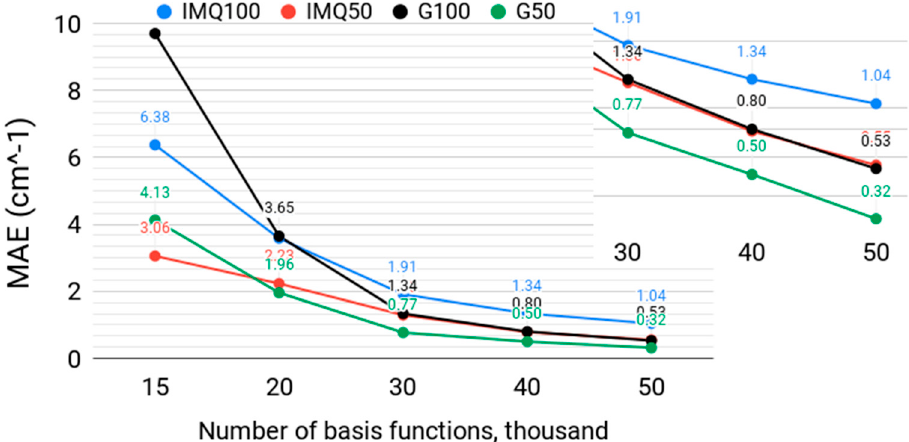
Figure 2. The mean absolute error (MAE), in cm − 1 , over the lowest 50 and 100 vibrational levels of H 2 CO, computed with a width-optimized inverse multiquadratic (IMQ50, IMQ100) basis with β = 7 and a width-optimized multiquadratic Gaussian (G50, G100) basis, for different numbers of basis functions N and M = 3 N collocation points. The insert shows part of the graph at the logarithmic scale.